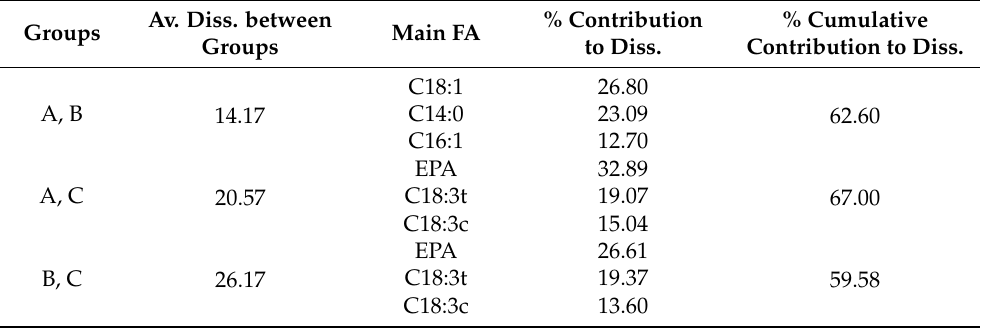
Table 6. SIMPER results regarding dissimilarities (diss.) between the groups identified (A— Laminaria ochroleuca ; B— Saccharina latissima ; C— Sacchorizha polyschides and Undaria pinnatifida ). Dissimilarities between different groups are provided by the average dissimilarity within each group (Av. diss. between groups)—the lower the dissimilarity (tending to 0), the higher the similarity within each group. The three FAs that contribute the most for the dissimilarity between groups are shown, as well as the percentage of that contribution and the cumulative contribution of those three FAs for the total dissimilarity between groups, in percentage. Replicates SL_R2 and SP_R3 were considered outliers of the analysis.